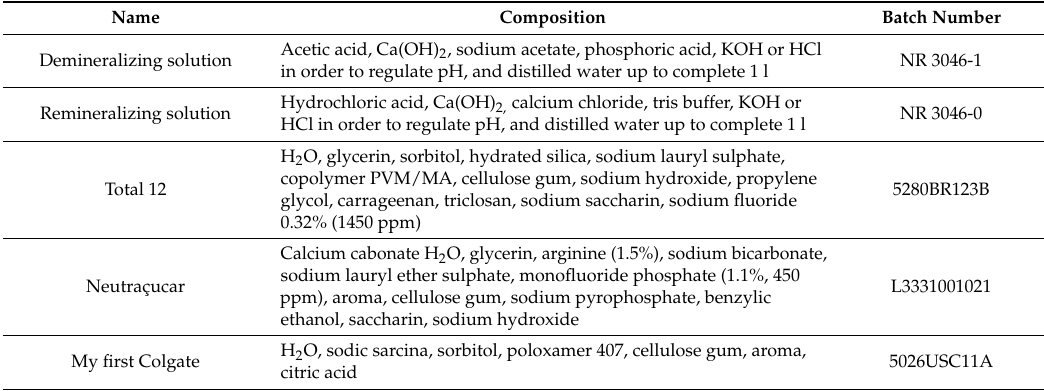
Table 2. Composition and batch number of dentifrices tested in this study. Also shown are the composition of the demineralizing and remineralizing solutions used in this